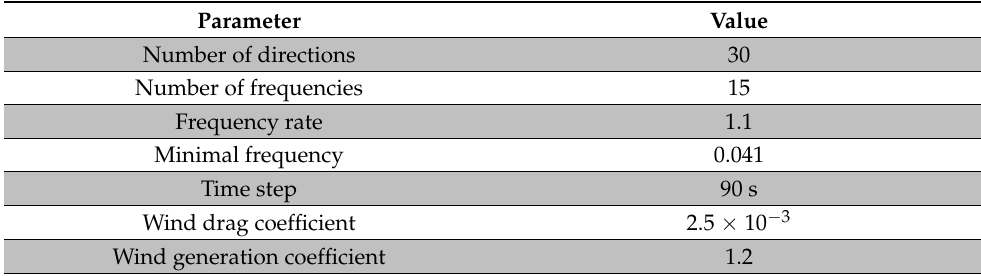
Table 2. Physical parameters used in the simulations with the wave module TOMAWAC.